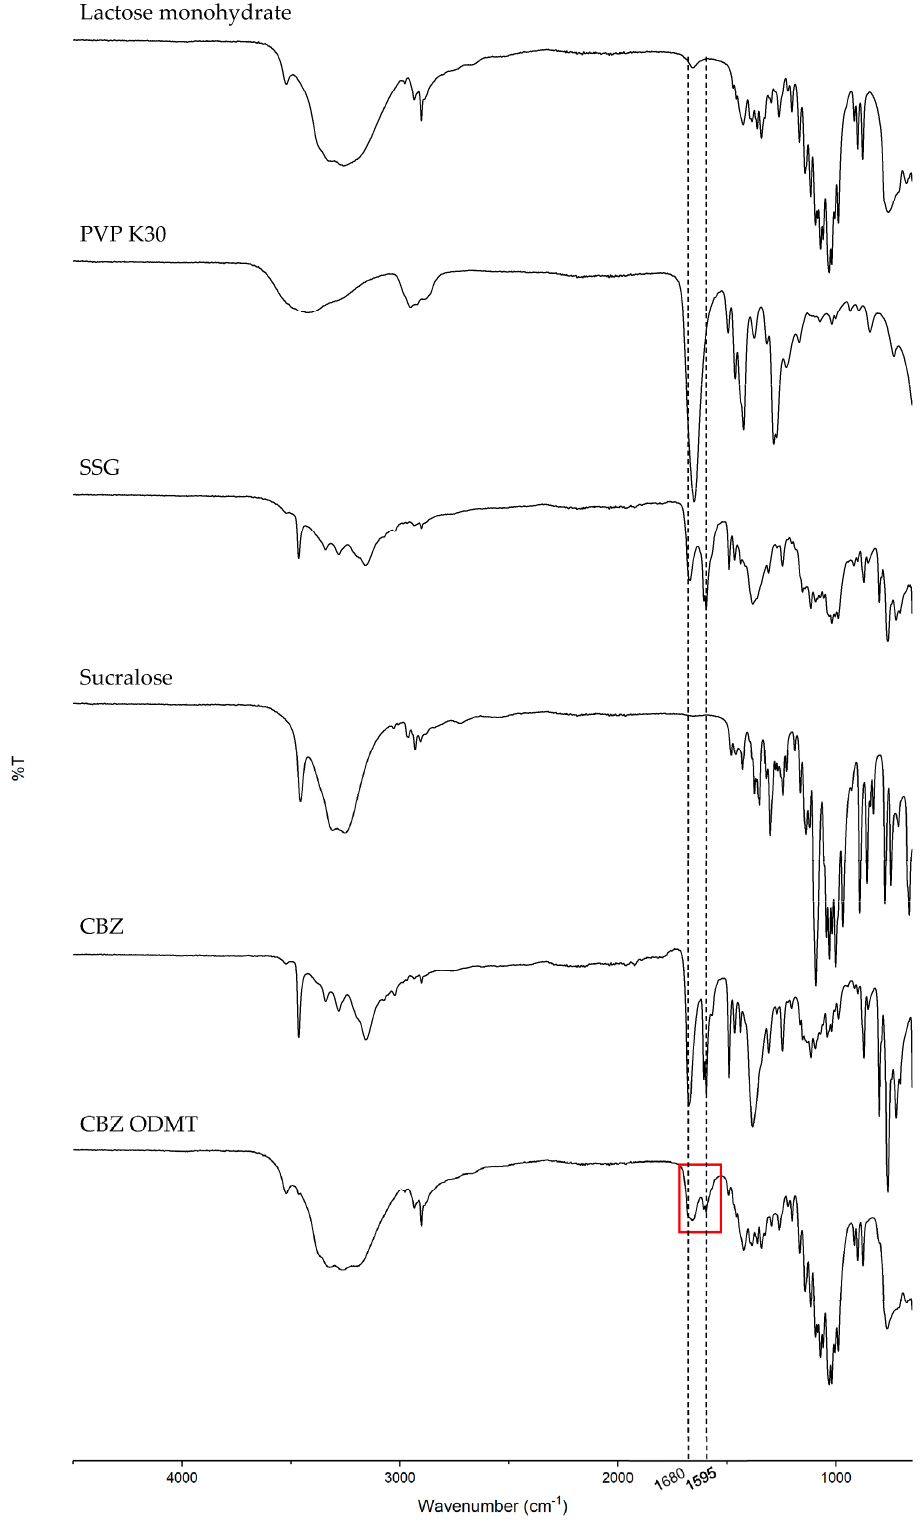
Figure 9. FTIR spectra of lactose monohydrate, PVP K30, SSG, sucralose and drug-loaded ODMTs; the red frame highlighted overlapping peaks of C-O group stretching and C=C group stretching.